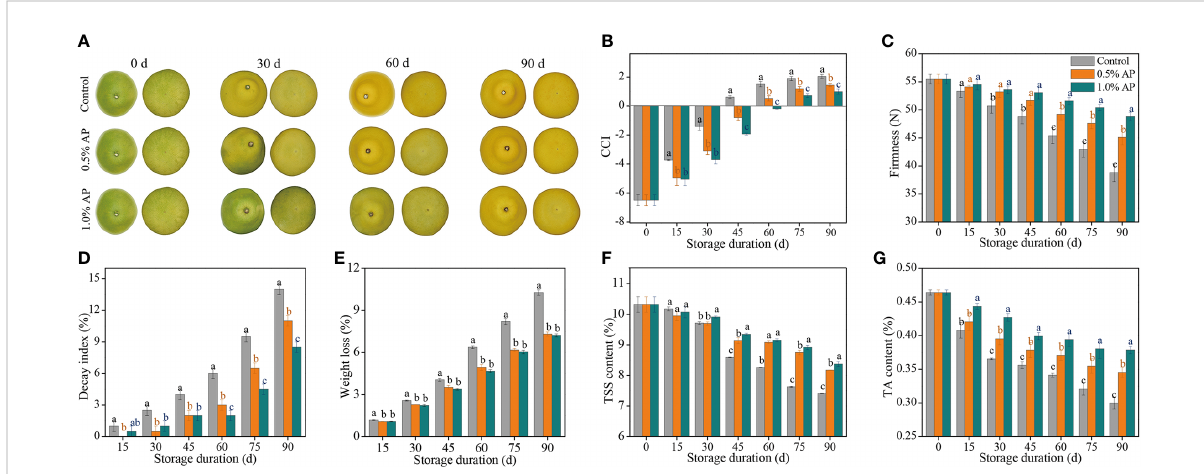
FIGURE 1 The inhibitory effects of pre-storage AP treatment on color development (A) , CCI (B) , fi rmness (C) , decay index (D) , weight loss (E) , TSS content (F) , and TA content (G) of harvested ‘ Jinshayou ’ pummelo fruit. The different letters for each same sampling point indicate signi fi cantly different at P < 0.05 according to Duncan ’ s multiple range